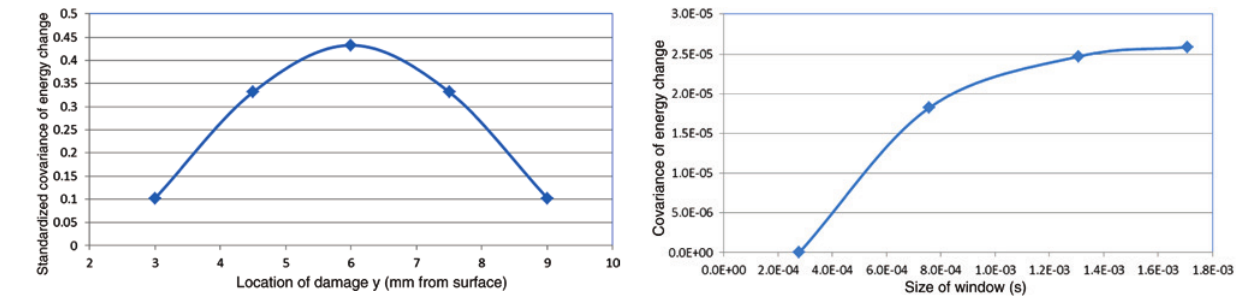
Figure 29: Covariance of energy change vs. distance of damage from center.